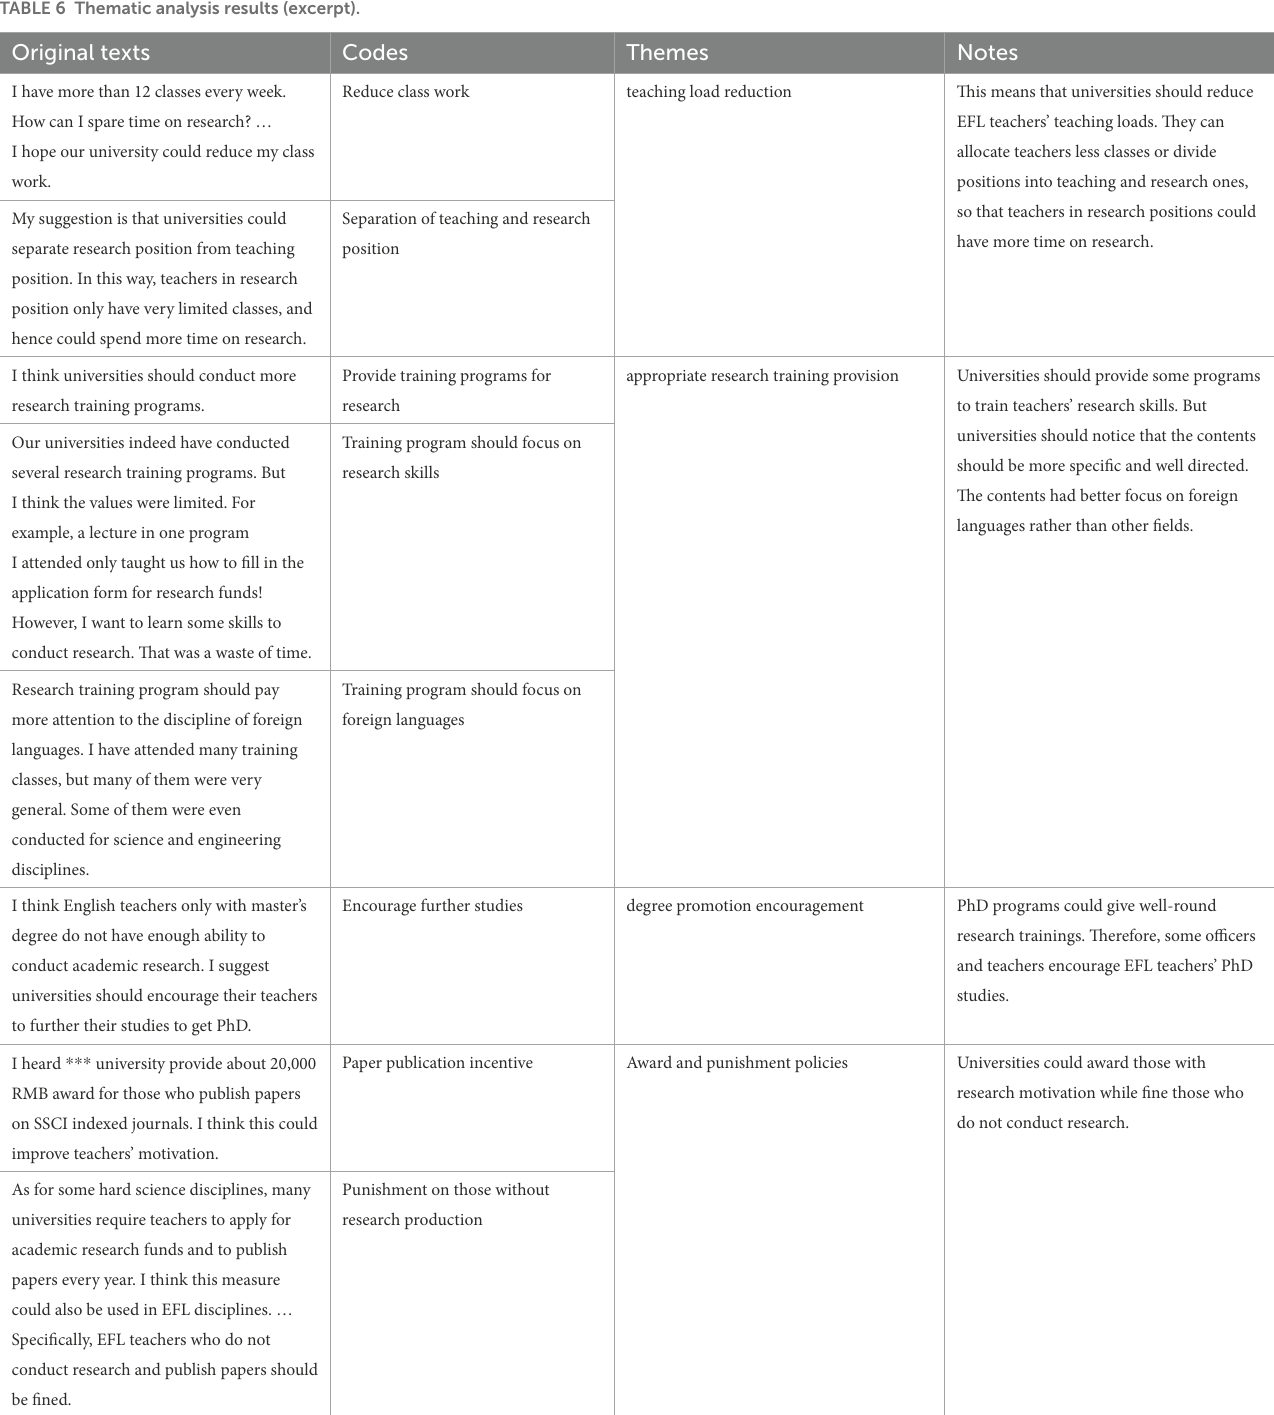
TABLE 6 Thematic analysis results